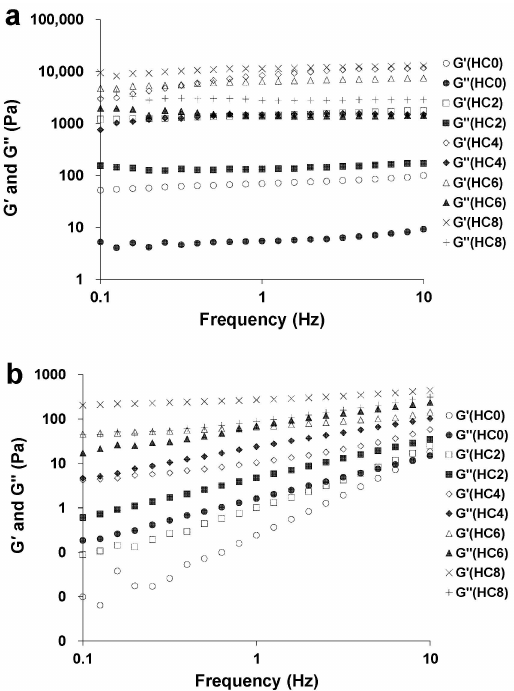
Figure 2. Frequency sweep curves of HPMC/CL blends at 82 ◦ C ( a ) and 25 ◦ C ( b